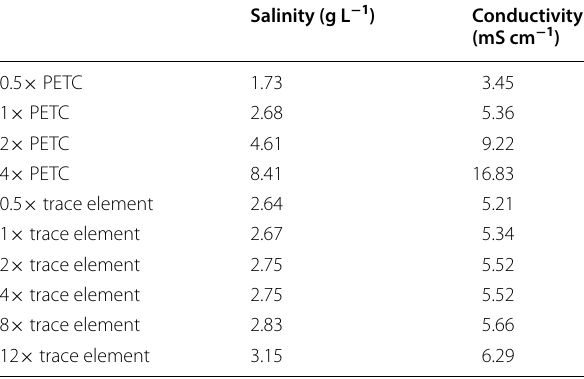
Table 1 Salinity and conductivity of different proportions of PETC solution and trace elements in catholyte